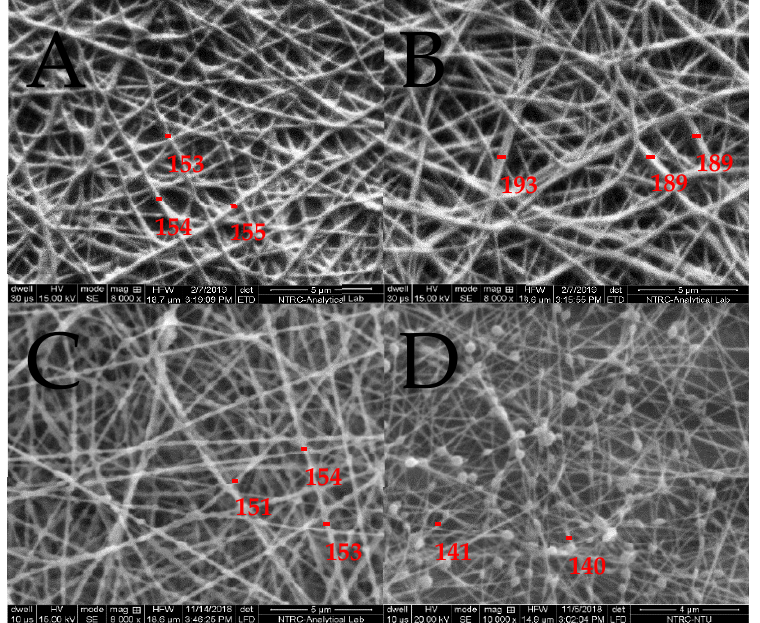
Figure 1. NFs formed with 0.5% of CEO ( A ), fibers formed with 1% of CEO ( B ), fibers formed with 60:40 ratio ( C ) and fibers formed with 70:30 ratio ( D ).